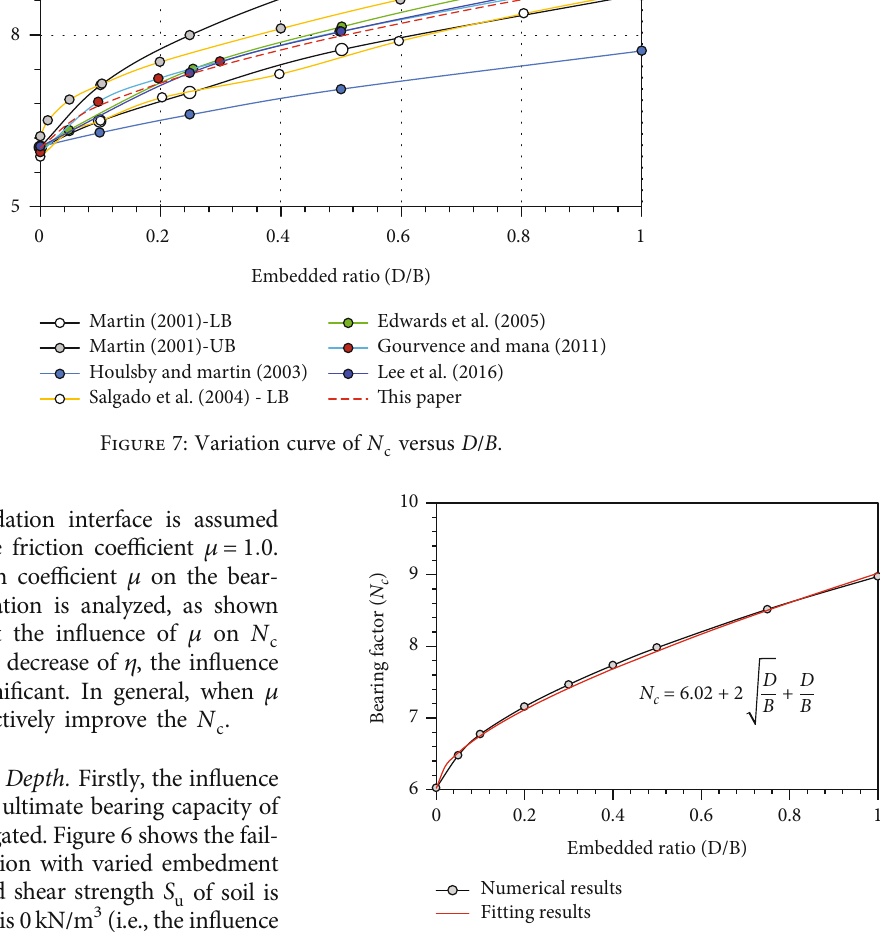
versus D / B for the circular c